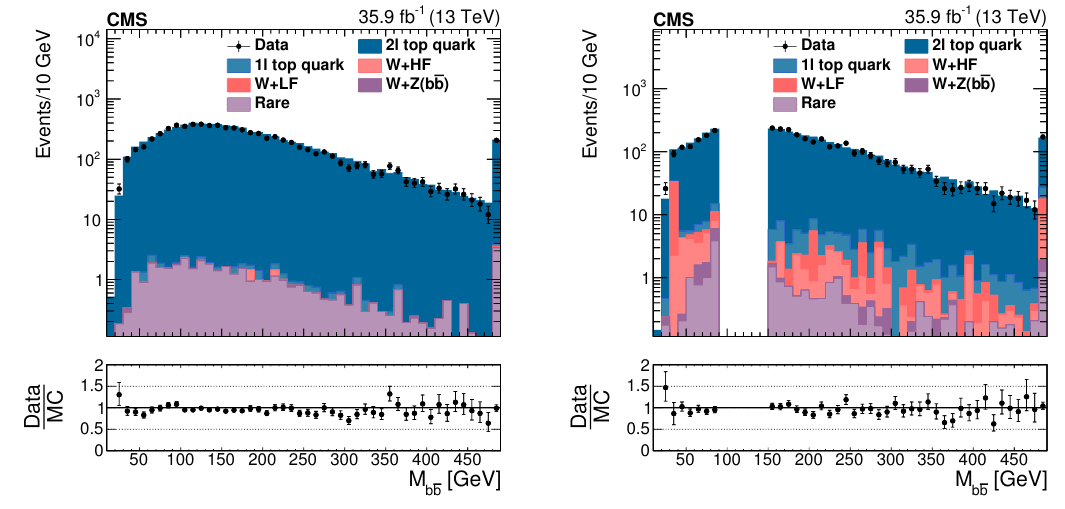
Figure 3 . (left) Distribution in M paring data to MC simulation. (right) Distribution in M de(cid:12)ned in table 1. The signal region range of 90 (cid:20) M